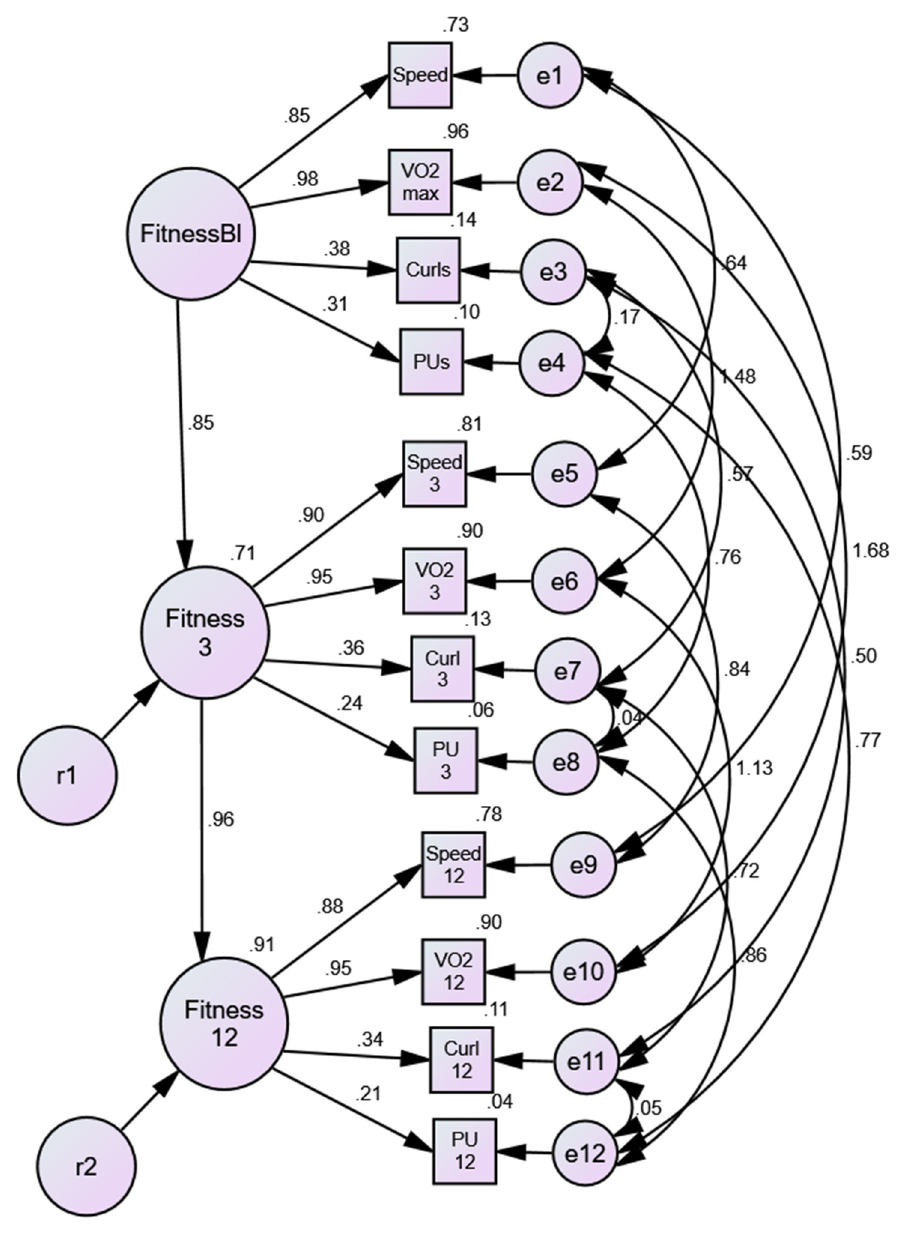
Figure 4. Disease invariance model. FitnessB1 = baseline; Fitness3 = 3-months; Fitness12 = 12-months Speed = treadmill speed; VO 2 max = age-sex percentile; Curls= Curl-ups; PU= Push-ups; e# and r# = error